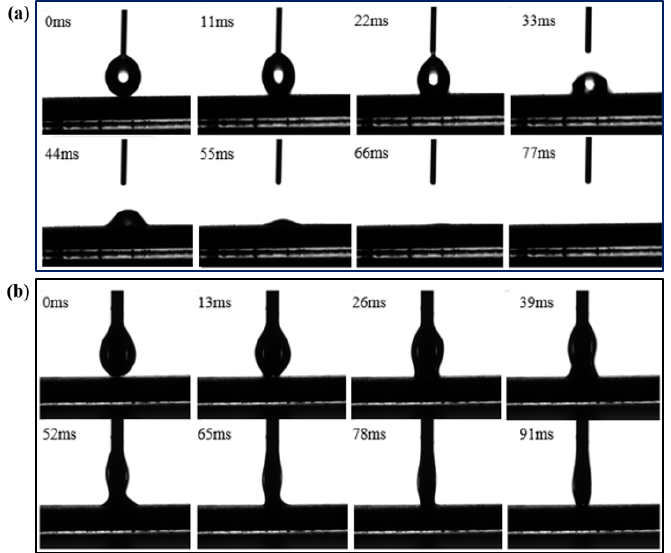
Figure 3. Spreading process of different working media on the surface of D6P4-05. ( a ) water, ( b ) ethanol.